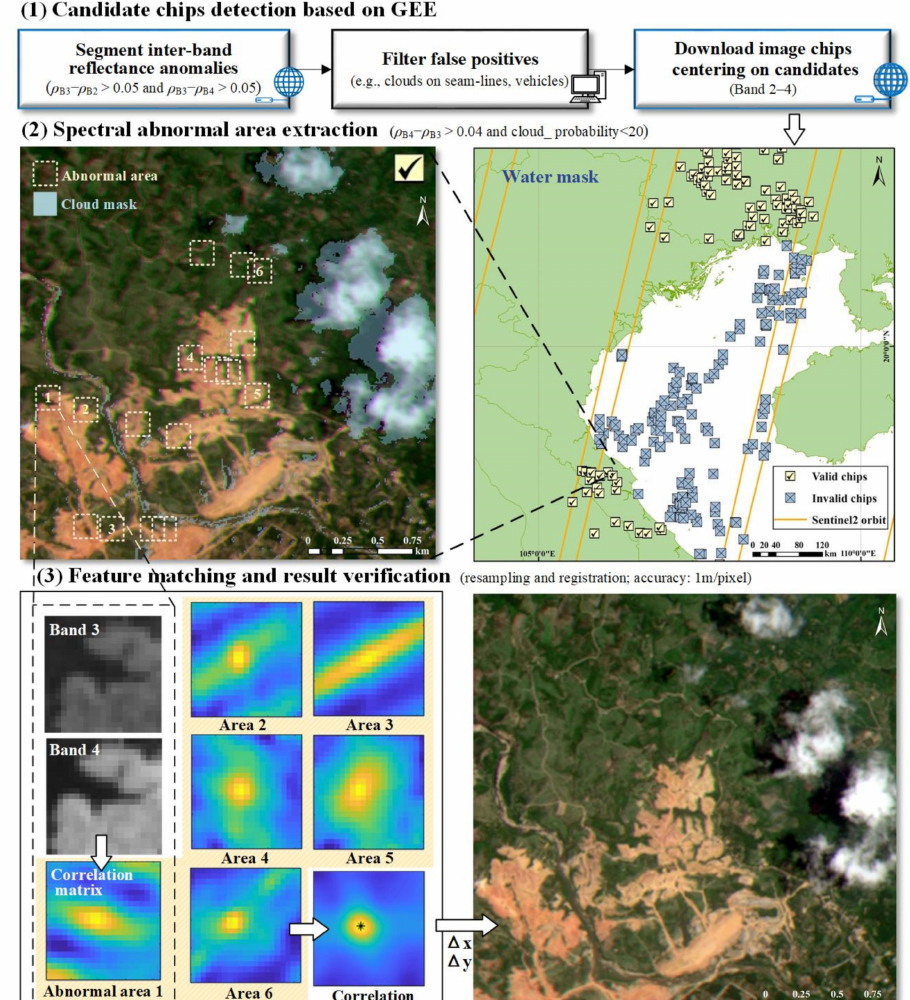
Figure 2. The hybrid framework of BBMR detection in an MSI image chip. The valid candidate chips (301 × 301 pixels) were selected after spectral anomaly detection and water masks. With the filtration of clouds, the abnormal areas inside the chips were extracted to calculate the best-fit location in the correlation matrix between visible bands. (The sample chip used in this figure was subsetted from scene